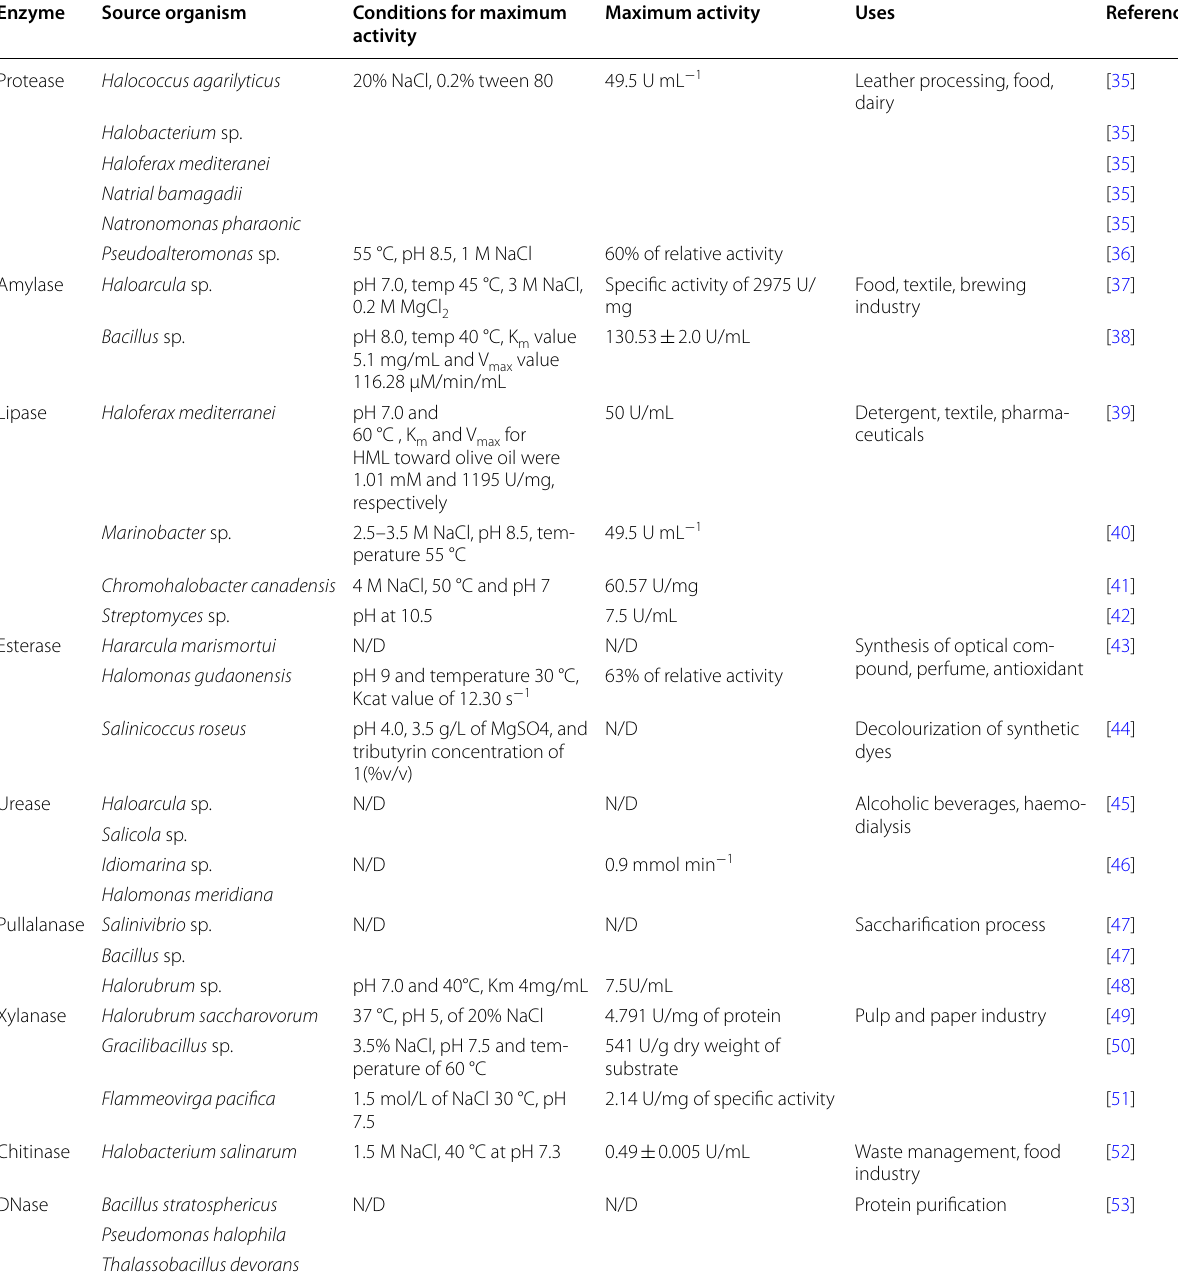
Table 1 A summarized overview of some enzymes produced by halophilic microorganisms and their industrial